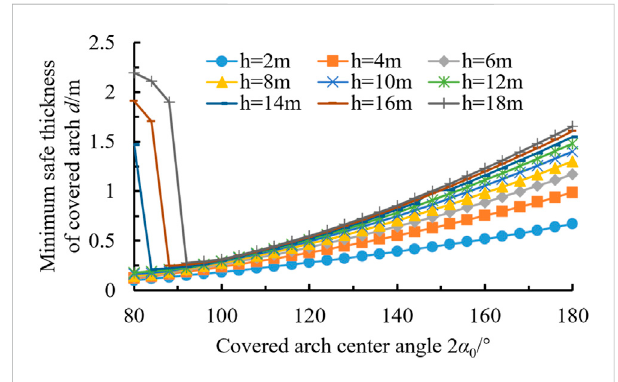
FIGURE 9 Relationship between thickness and covered arch central angle with different tunnel depth (case